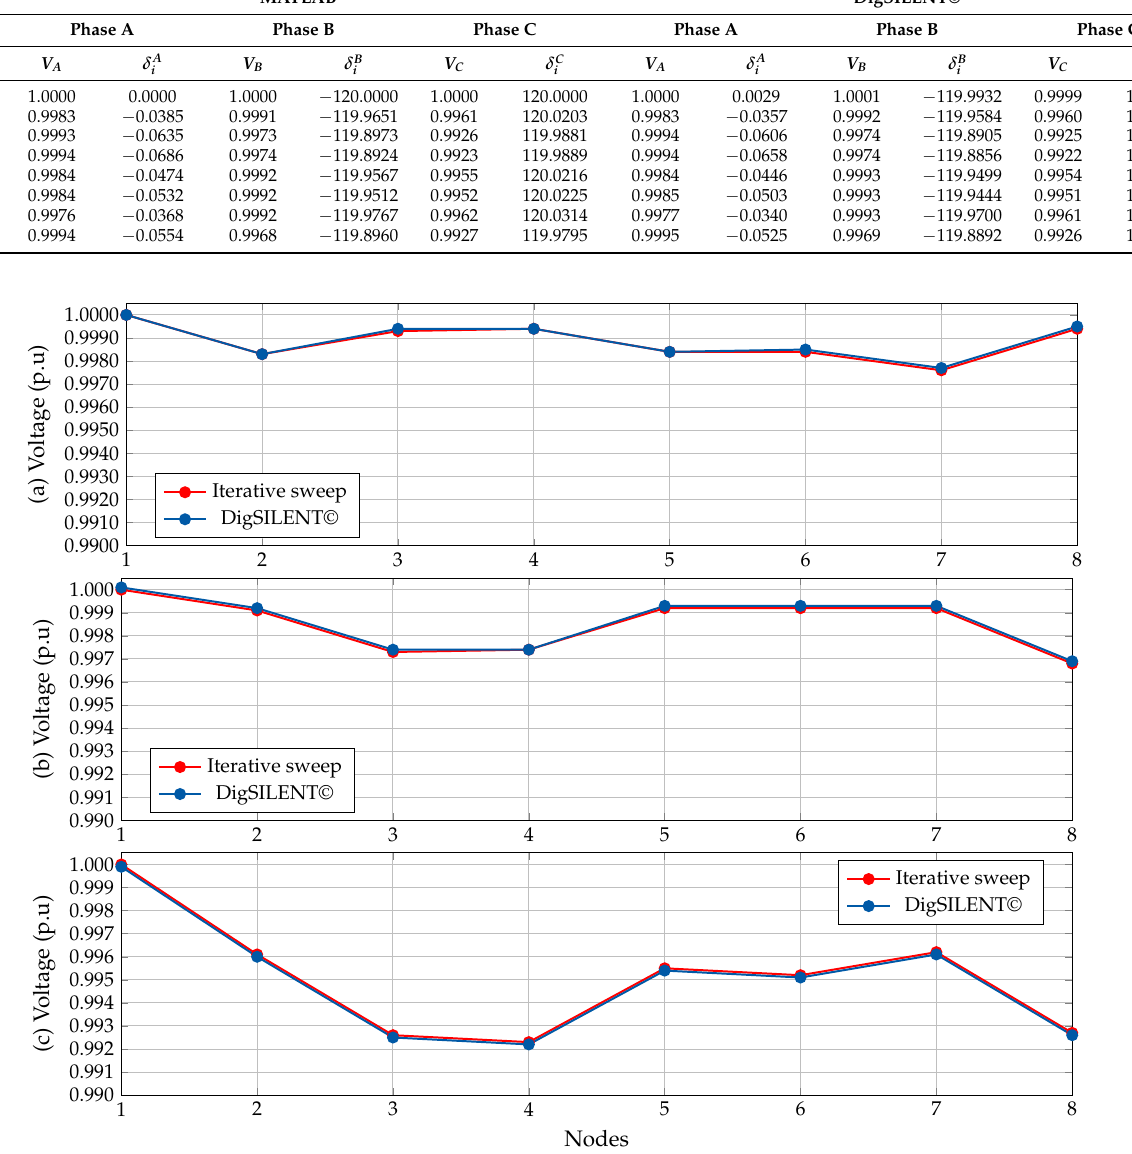
Figure 9. Voltage profiles in the 8-node test system: ( a ) phase A, ( b ) phase B, and ( c ) phase